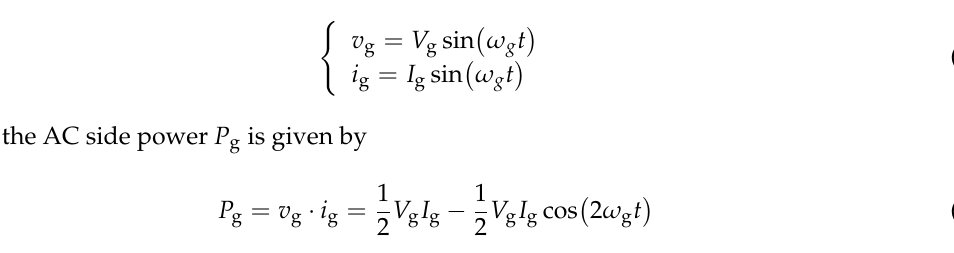
Figure 7. Two working modes of the integrated buck/boost stage ( a ) Buck mode with i s > 0; ( b ) Boost mode with i s < 0.